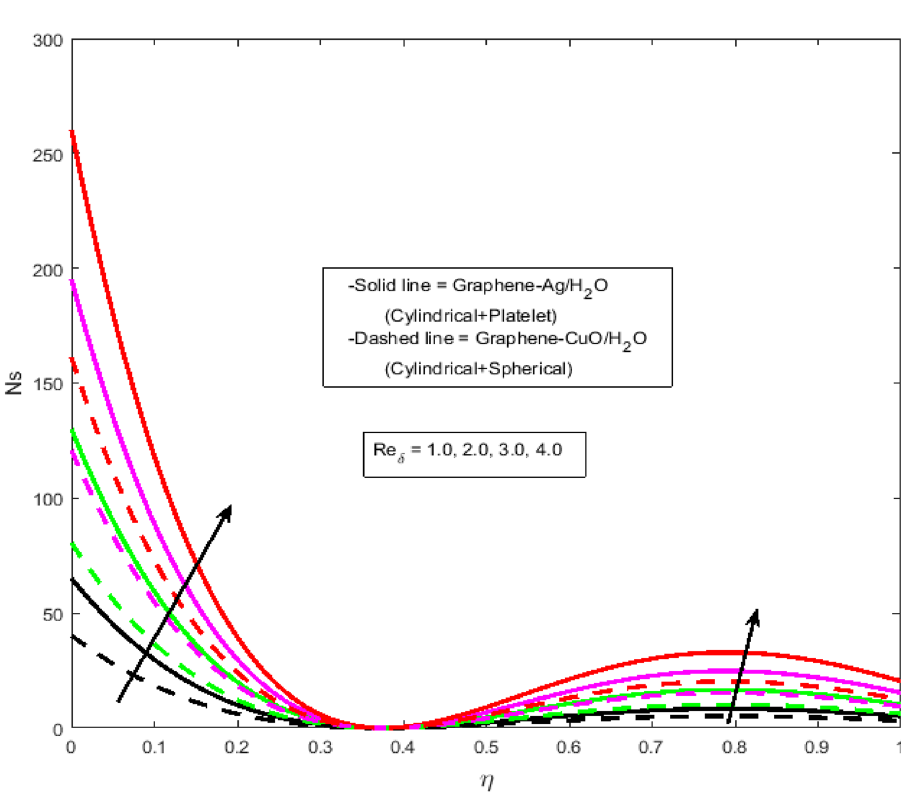
Figure 10. Effect of Re δ on Ns